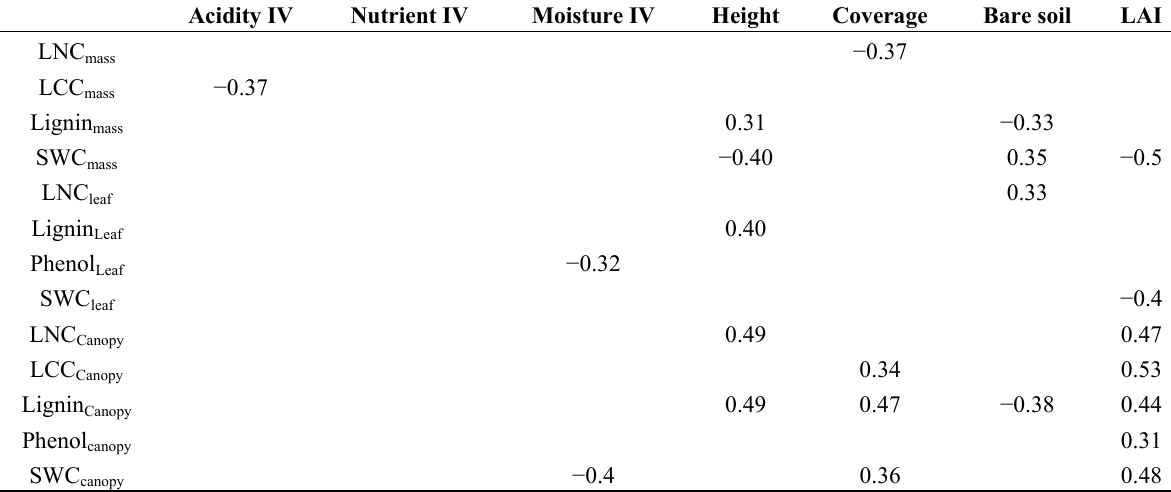
Table 1. Correlation coefficients between model residuals and plot co-variables. Shown are correlations significant at p = 0.05. Note that residuals of traits models absent in this table do not correlate significantly with any of the plot